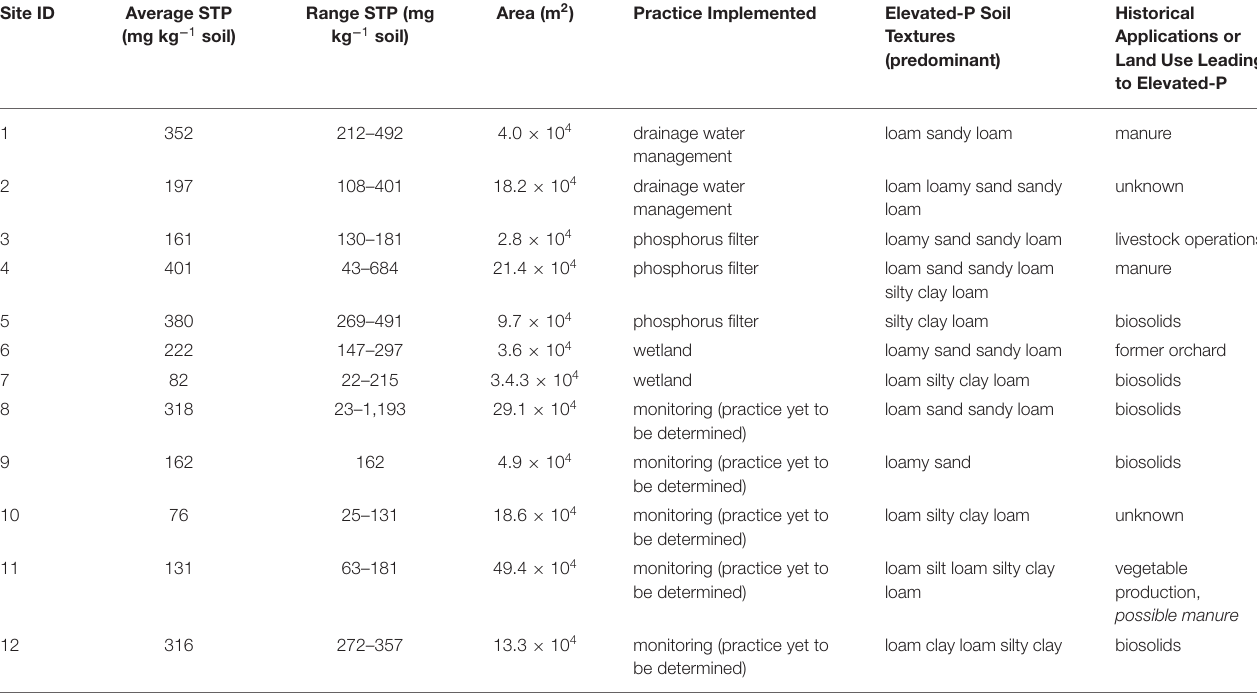
TABLE 1 | Project sites and characteristics.